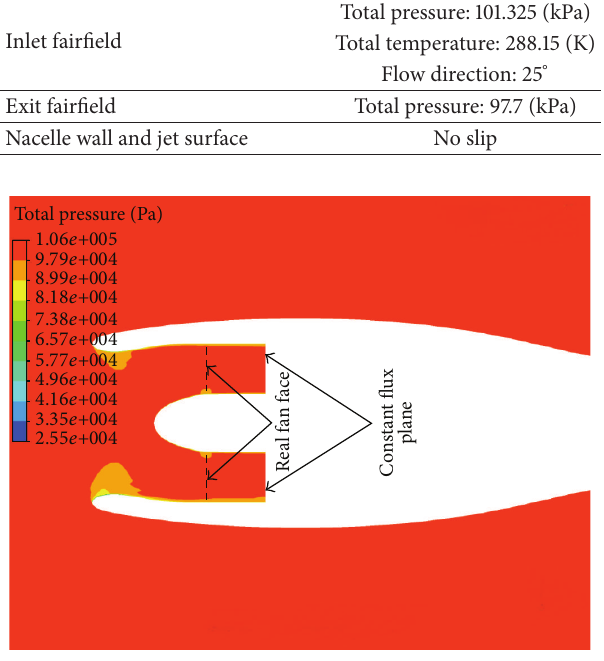
Figure 15: Contours of the total pressure for the constant mass flux model.